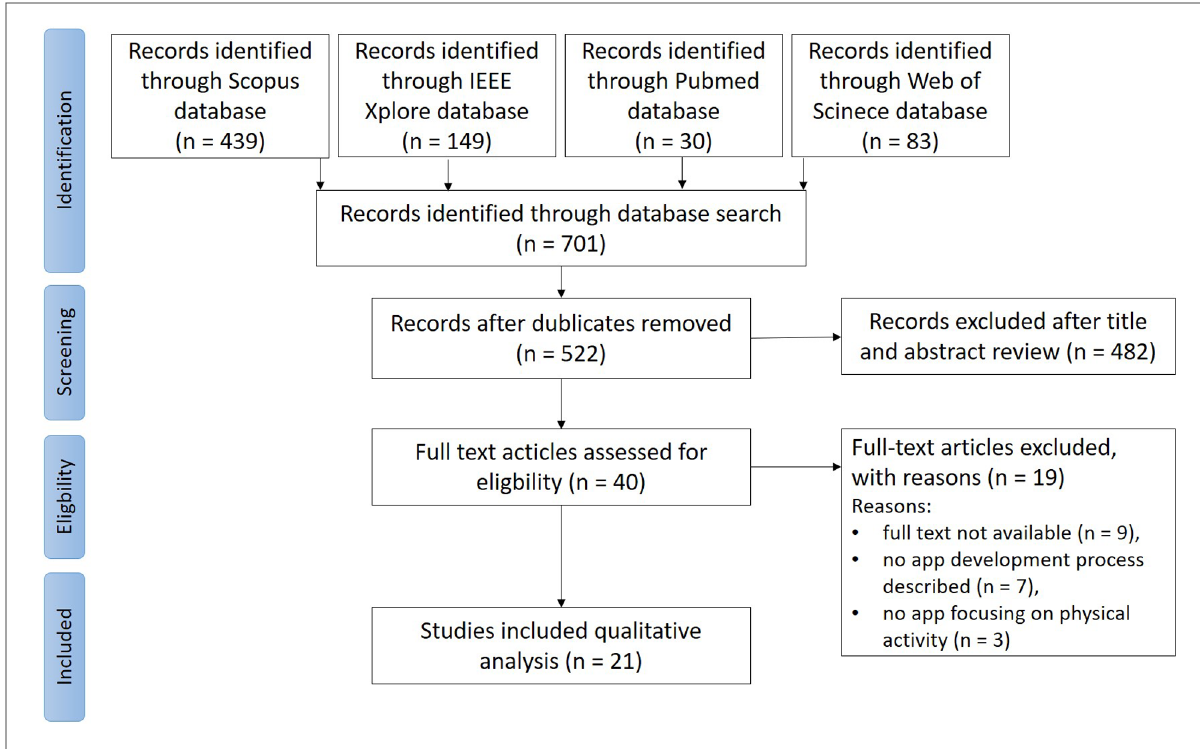
FIGURE 1 PRISMA (preferred reporting items for systematic reviews and meta-analyses)